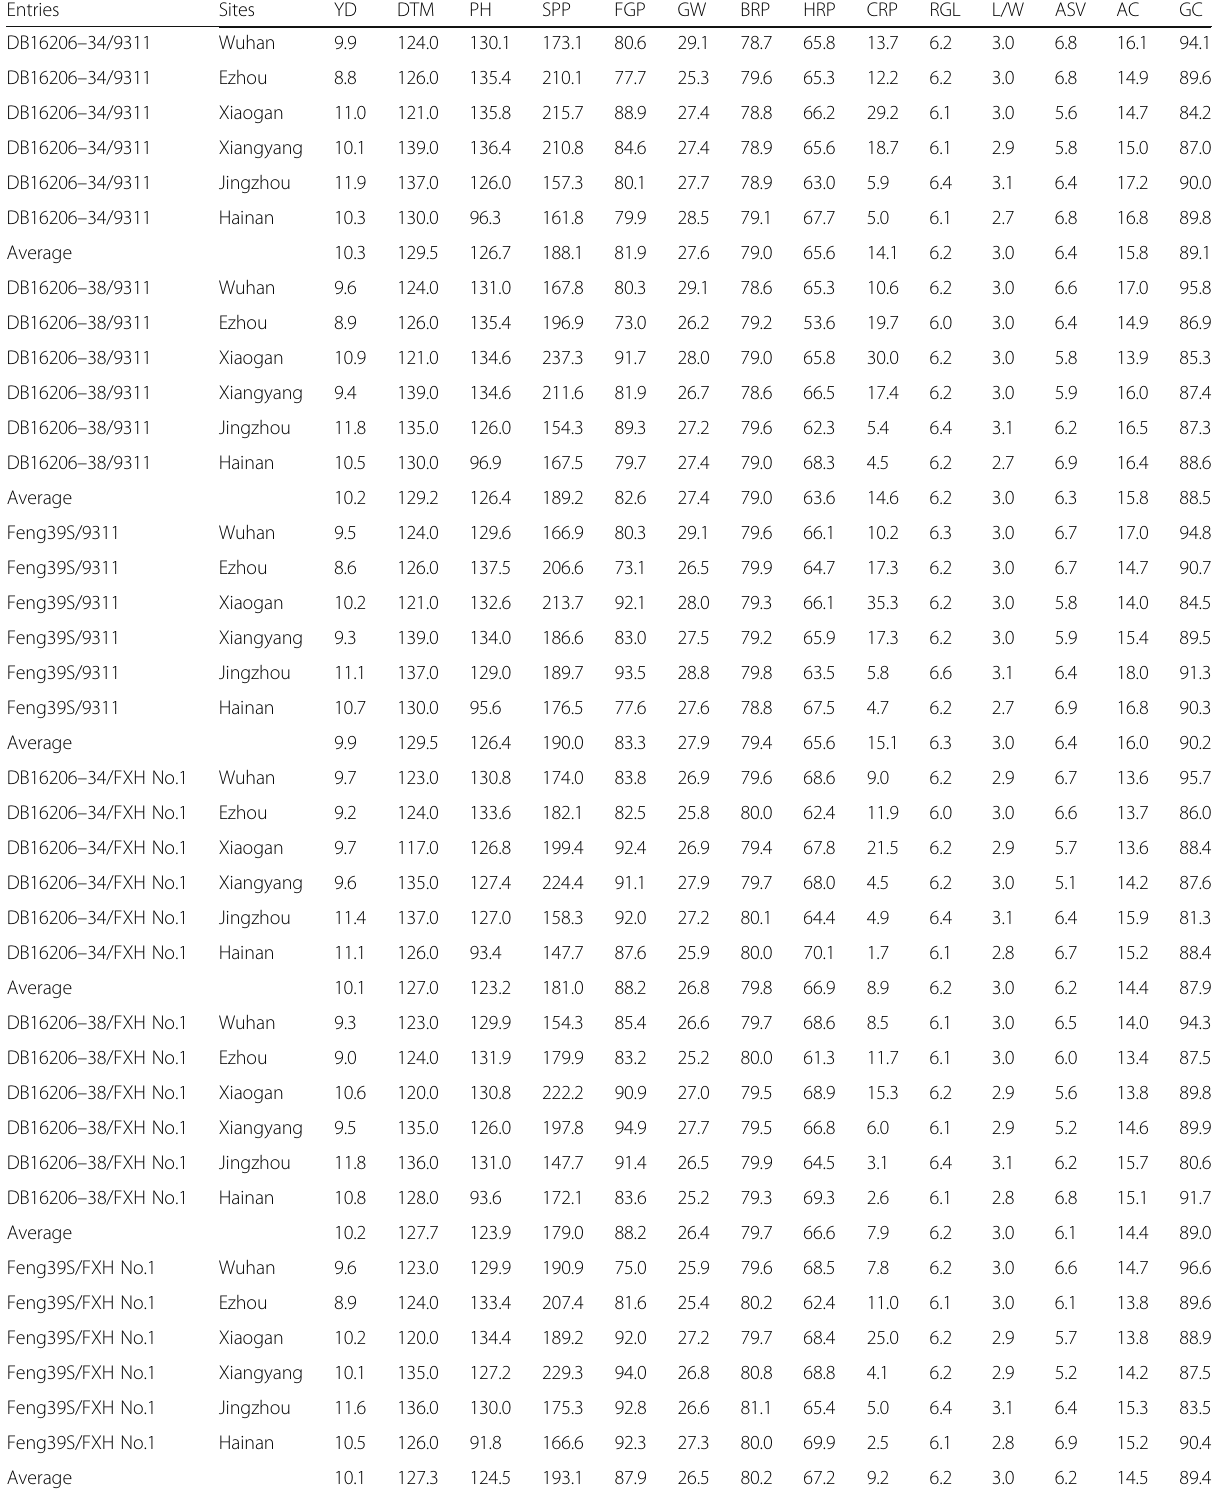
Table 7 The performance of yield, main agronomic traits, and rice quality of hybrids in multi-site trials Entries